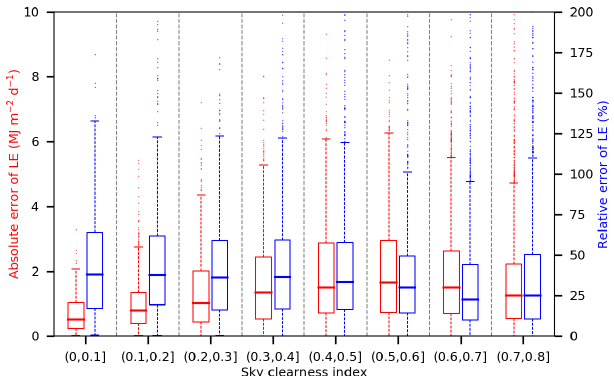
Figure 12. BESS-STAIR estimated daily ET has a similar perfor- mance with a varying sky clearness index (the ratio of incoming ra- diation on the surface to that on the top-of-atmosphere). The lower and upper boundaries of boxes refer to the first and third quartiles of error statistics. The bars inside the boxes refer to median values. The whiskers indicate 1.5 times the distance between the first and third